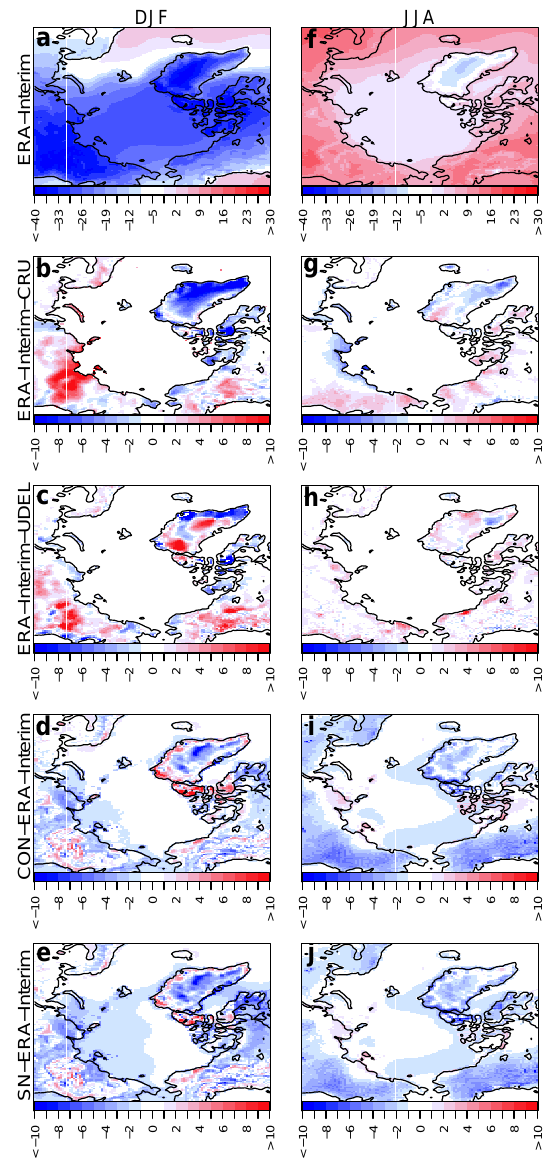
Fig. 8. Two-metre temperature of ERA-Interim (a, f) , and its bias to CRU (b, g) and UDEL data (c, h) . The bias of the CON (d, i) and SN (e, j) are shown relative to ERA-Interim. Results are shown for Fig. 8. Two metre temperature of ERA-Interim (a,f), and its bias to DJF (left) and JJA (right). Units are given in K. CRU (b,g) and UDEL data (c,h). The bias of the CON (d,i) and SN (e,j) are shown relative to ERA-Interim. Results are shown for DJF (left) and JJA (right). Units are given in K. nents (see Fig. 9b–c and g–h). RCA simulates more